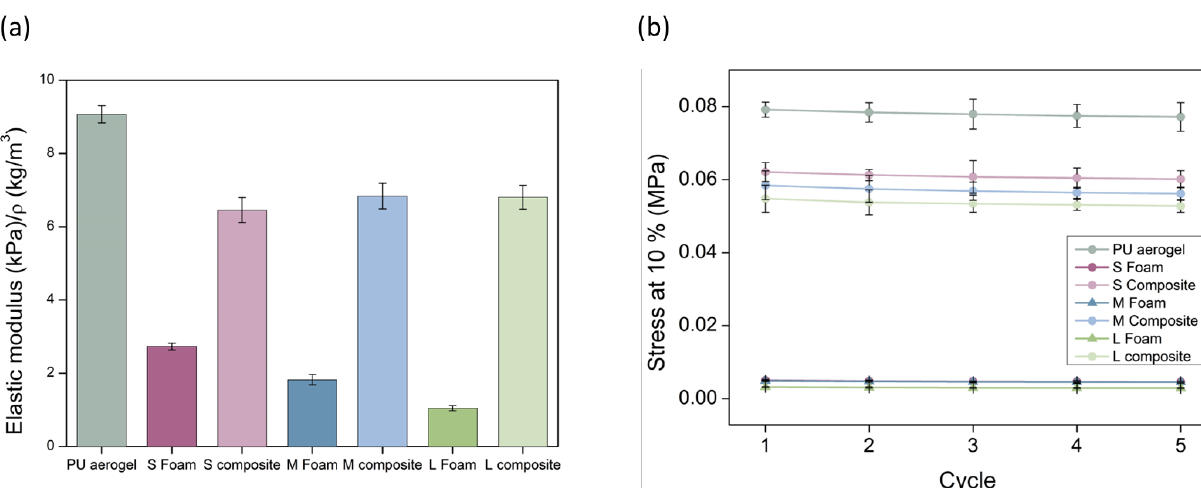
Figure 7. ( a ) Normalized elastic moduli for all the samples. ( b ) Stress at a strain of 10% for each compression–decompression